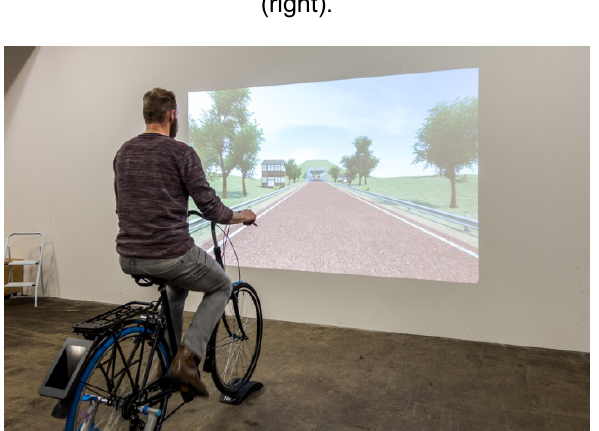
Figure. 5. The cycling simulation system under development.